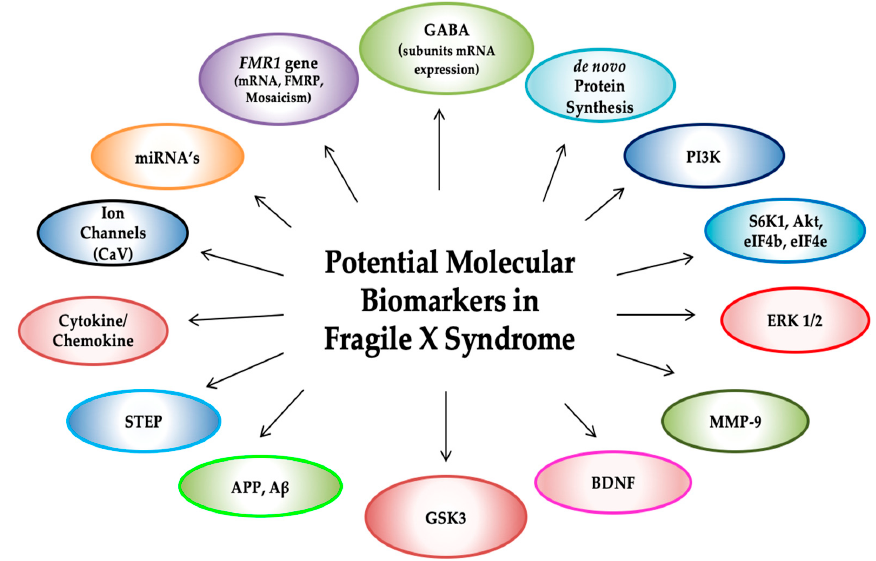
Figure 2. Candidate molecular biomarkers for FXS include a number of targets and substrates of several signaling pathways, in addition to fragile X mental retardation 1 ( FMR1 ) molecular measures and metabolites, of which expression levels or activity have been found dysregulated in FXS animal models and in human FXS tissues. Fmr1 mRNA and fragile X mental retardation 1 protein (FMRP) expression, de novo protein synthesis, γ -aminobutyric acid (GABA) receptors (GABA A and GABA B ), phosphoinositide 3-kinase (PI3K), extracellular-regulated kinase (ERK), matrix metalloproteinase-9 (MMP-9), brain-derived neurotrophic factor (BDNF), mammalian target of rapamycin (mTOR), p70 ribosomal S6 kinase (S6K1), ion channels (KNa, BKCa, CaV, Kv, HCN1), bone morphogenetic protein receptor Type 2 (BMPR2), Diacylglycerol Kinase Kappa (Dgk κ ), endocannabinoid system (eCS), amyloid- β protein precursor (APP), microRNA’s (miRNA’s), striatal-enriched protein tyrosine phosphatase (STEP), glycogen synthase kinase-3 (GSK-3) cytokine and chemokine profiles, metabotropic glutamate receptor